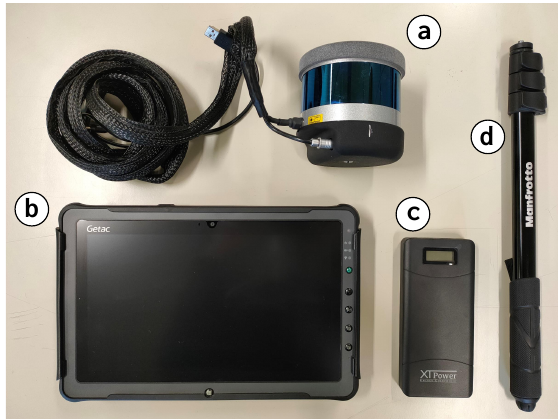
Figure 1. Main components of the HERON Lite handheld system. (a) Sensor head (Velodyne Puck LITE laser scanner + XSens MTI IMU), (b) control unit, (c) battery, (d) telescopic